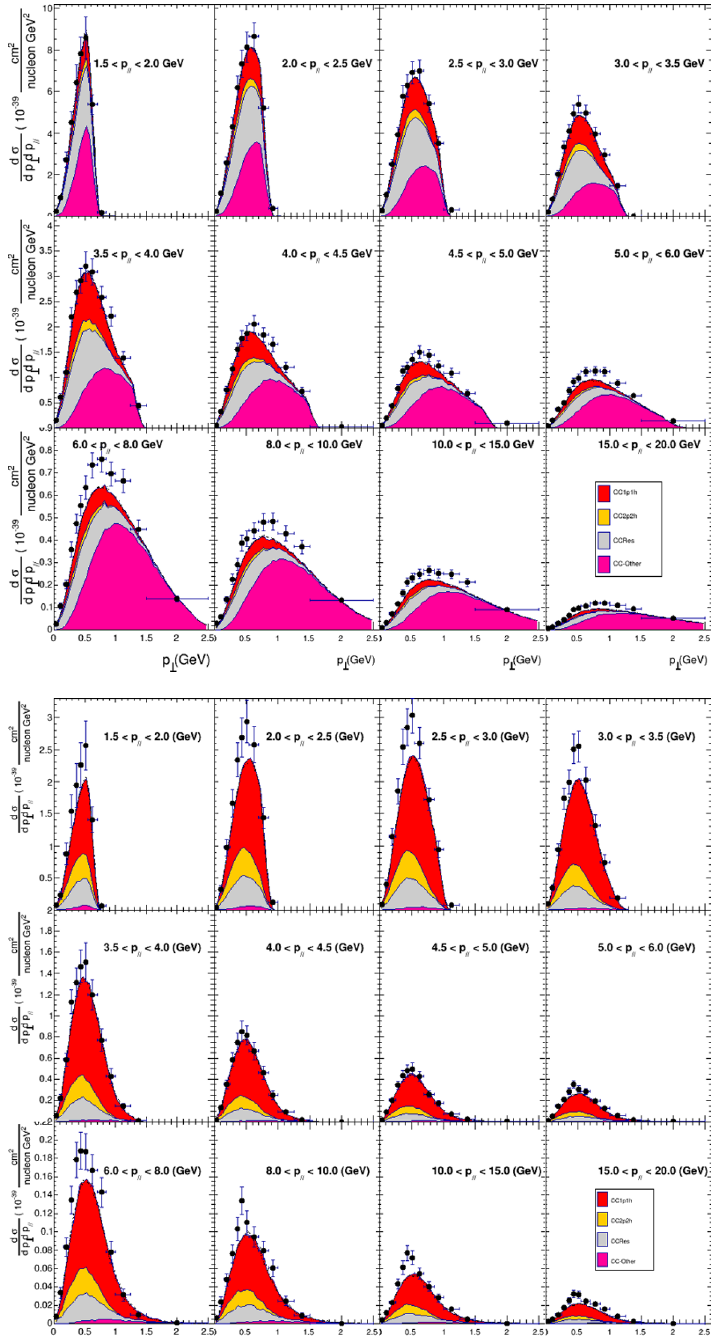
Figure 6 . MINERvA CC (top) and CC0 π (bottom) inclusive double differential cross-section . Data, taken from refs. [16] and [17], respectively, are compared to the results obtained d 2 σ/dp ⊥ dp k from the present implementation of NEUT, with the χ 2 -likelihood tests compiled in table